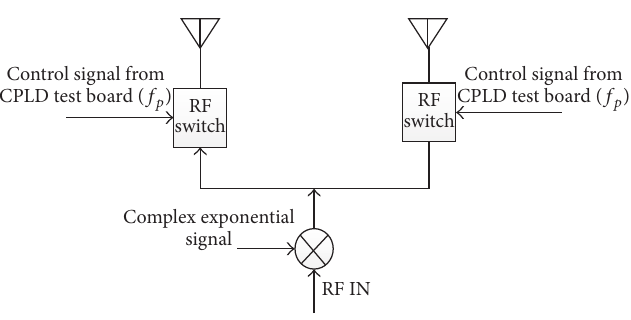
Figure 1: Simplified block diagram of the proposed